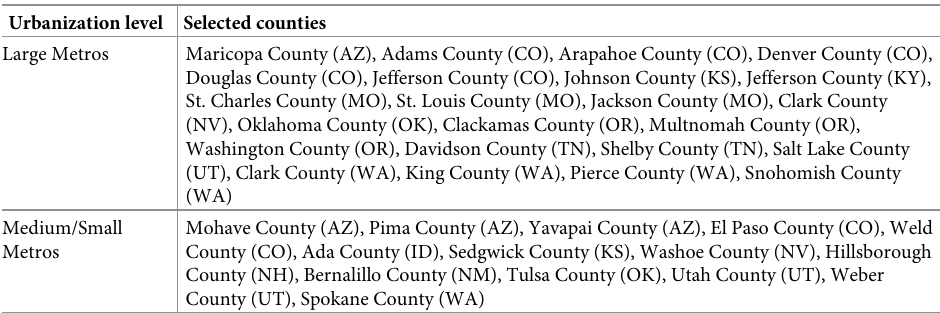
Table 1. Study samples.